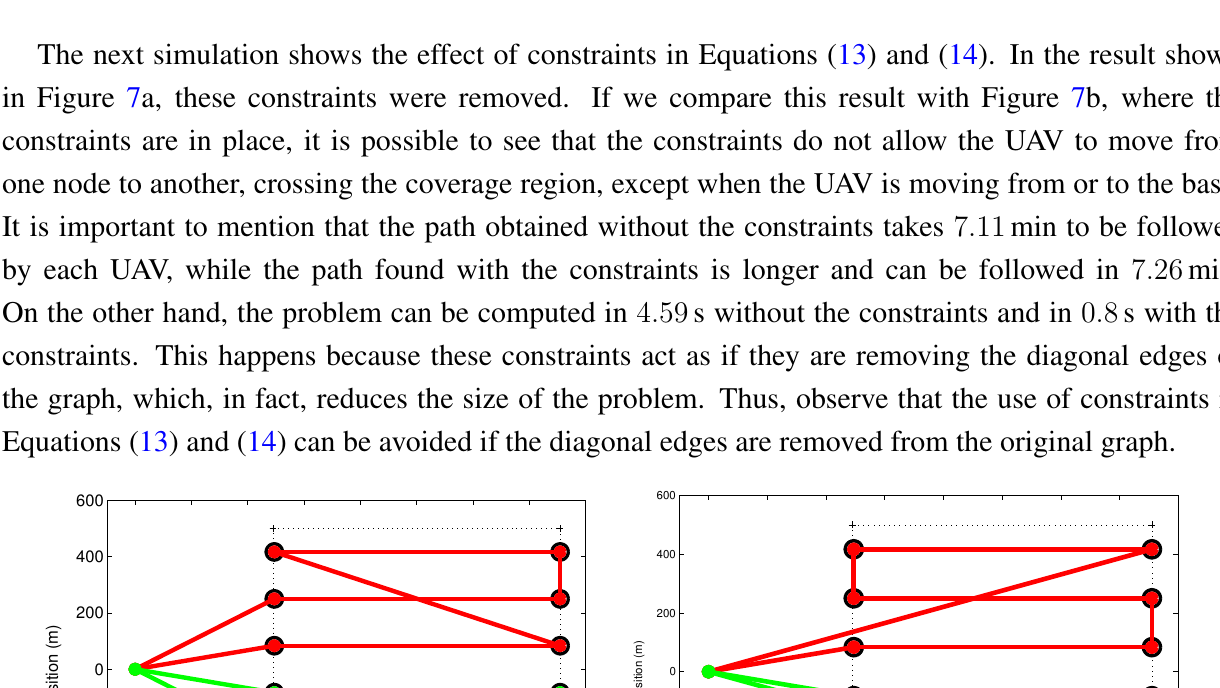
Figure 6. Effect of constraint in Equation (12). The solid lines represent the paths for the two UAVs used in the simulation. Optimization results without ( a ) and with ( b ) the constraint.